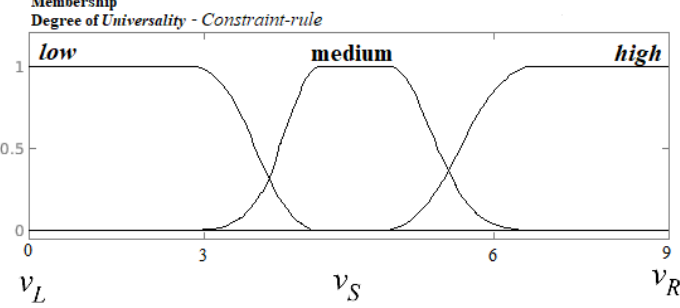
Figure 2. Linguistic Universality of the representative set as a Evaluative